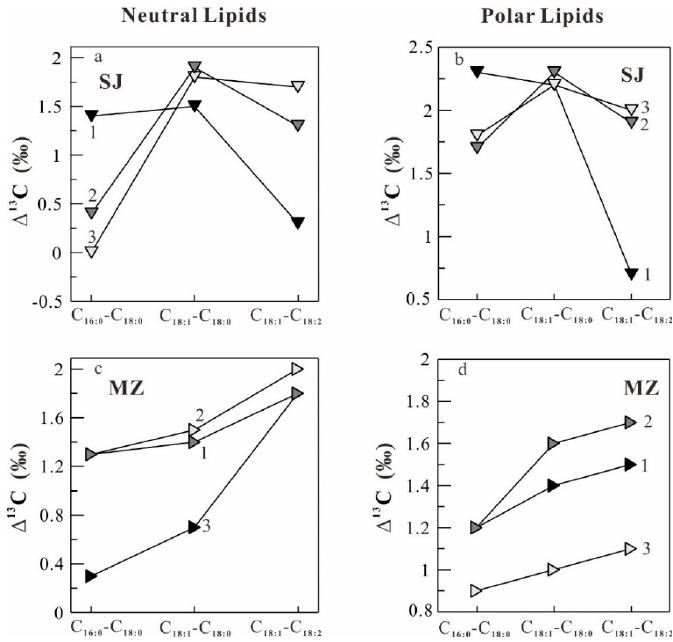
Figure 5. Difference of the δ 13 C values of major fatty acids ( ∆ 13 C) between the samples from Sejila Mountain (SJ, ( a ) and ( b )) and Maizhokunggar (MZ, ( c ) and ( d )). ( a , c ) and ( b , d ) refer to neutral and polar lipids, respectively.